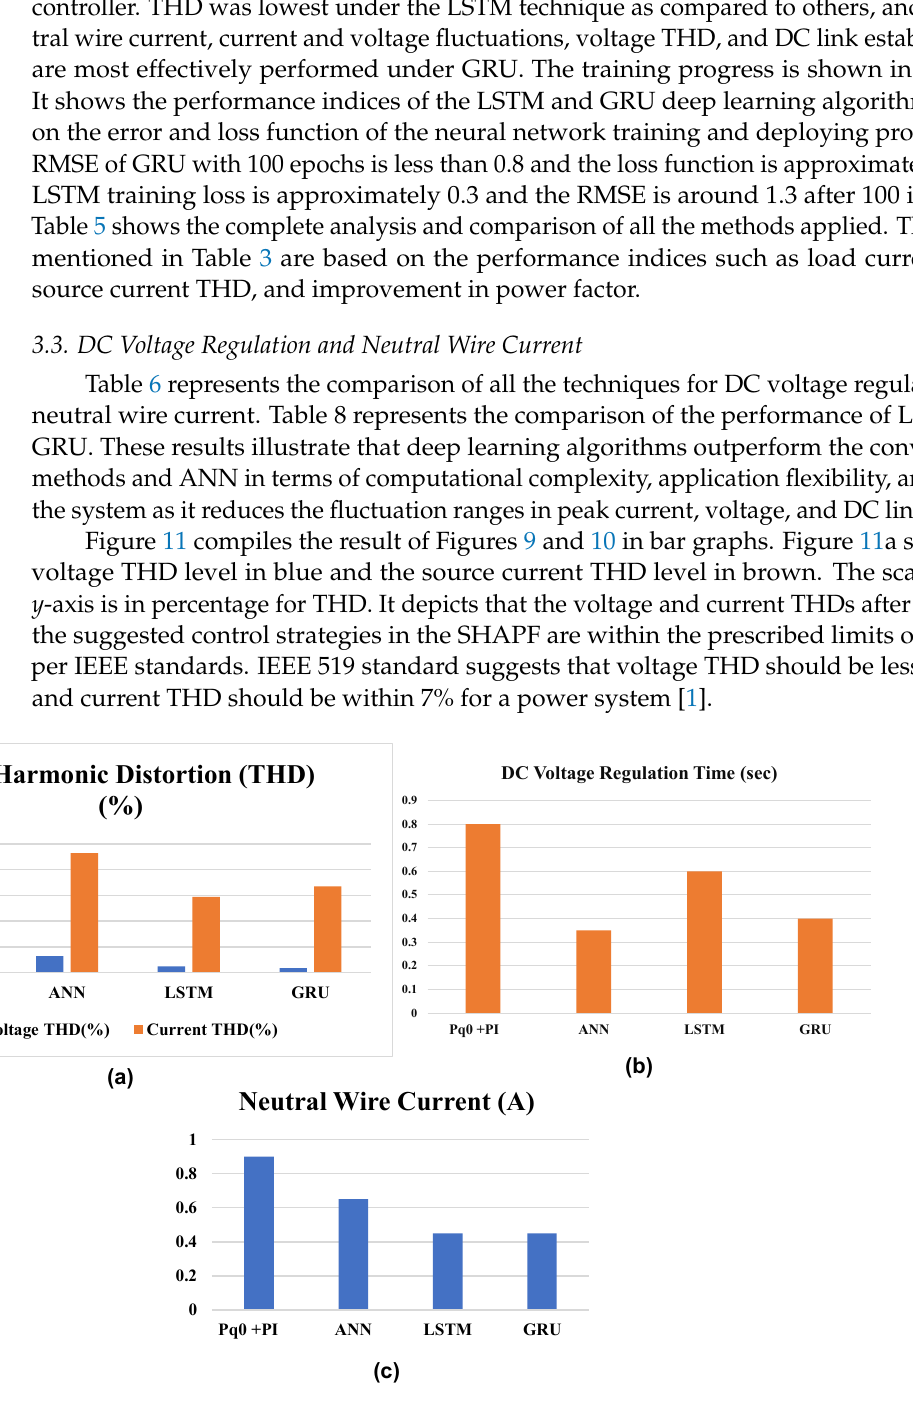
Figure 11. Case 1 ( a ) voltage and source current THD (%); ( b ) DC link establishment time (s); ( c ) neutral wire current (a).